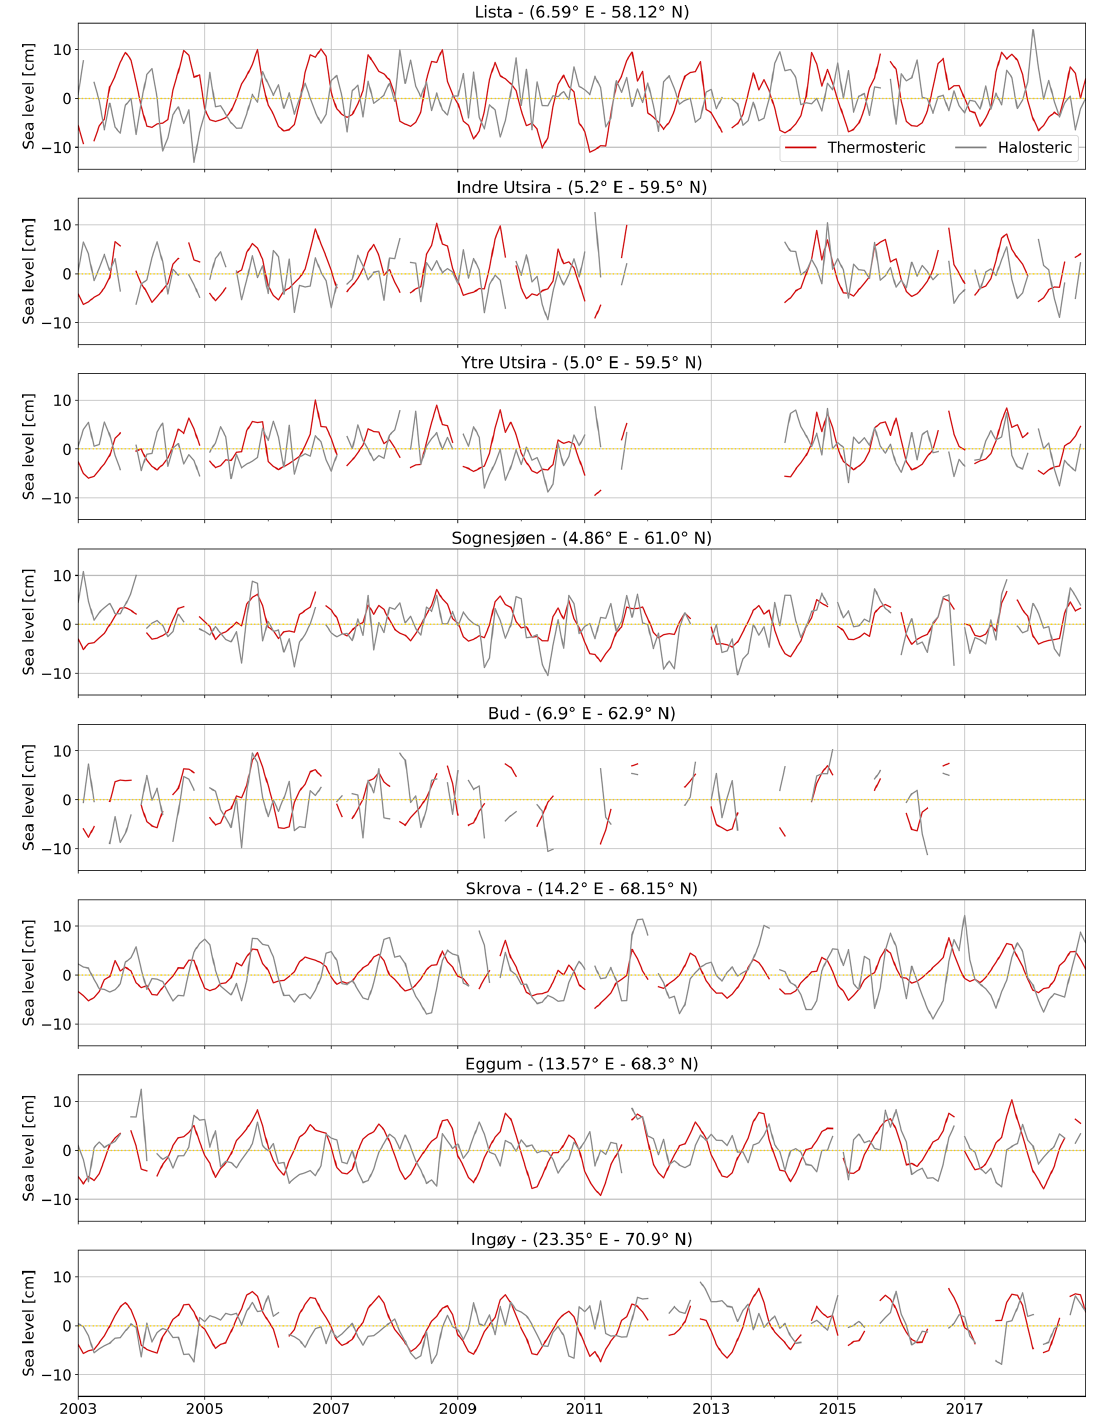
Figure 11. Thermosteric (red) and halosteric (gray) components of the sea-level anomaly at each hydrographic station along the Norwegian